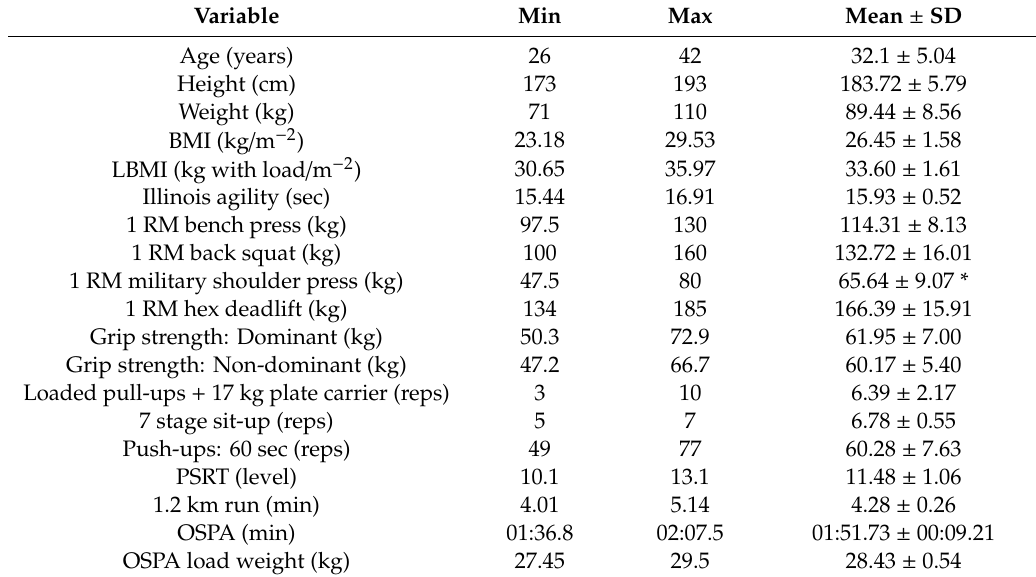
Table 1. Descriptive data for demographic, anthropometric, physical fitness and occupational task performance measures in specialist police